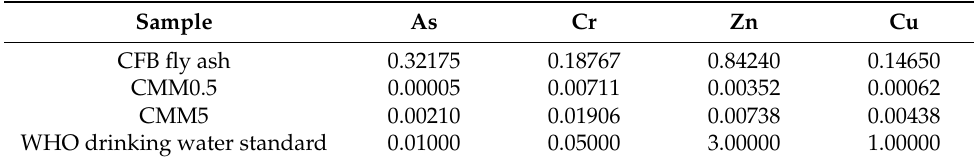
Table 7. Leaching results of heavy metals